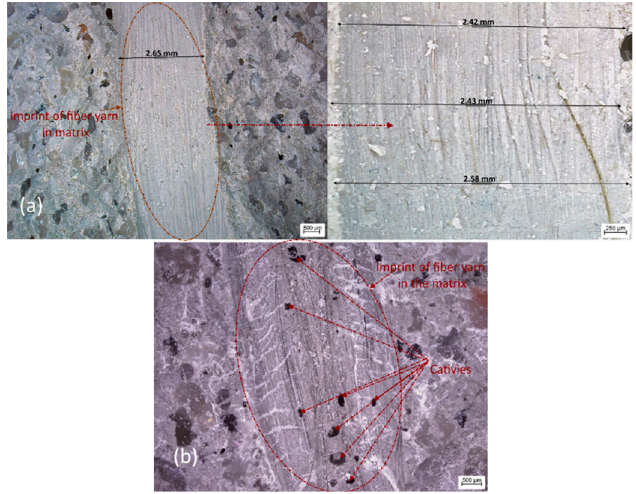
/ fiber yarn interface: (a) BRG 10 × 14-4 L; (b) BRG 22 × 22-3 Figure 13. Geopolymer matrix/fiber yarn interface: (a) BRG 10 × 14-4 L; (b) BRG 22 x 22-3 L. Figure 13. Geopolymer matrix